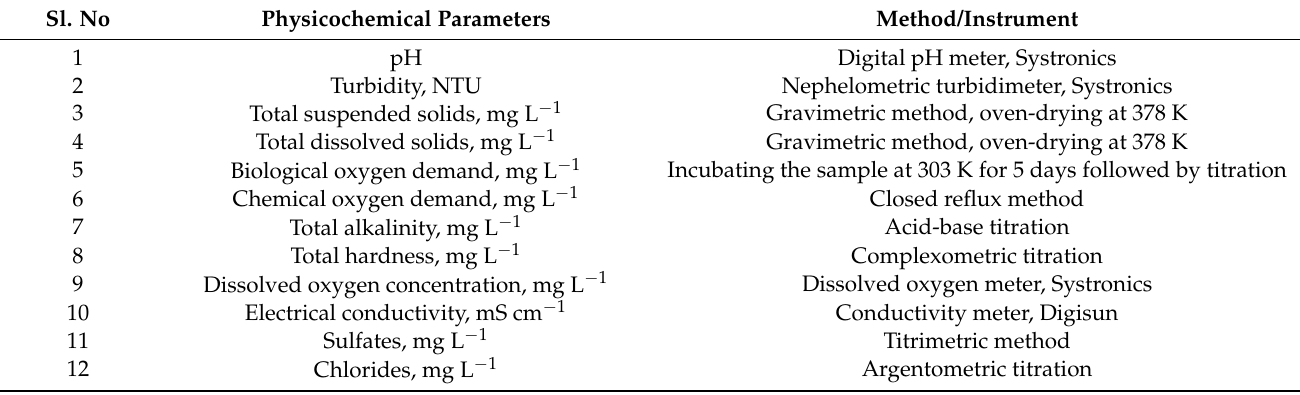
Table 1. Methodology used to analyze the textile industrial Congo red (CR) dye effluent using standard operating procedures